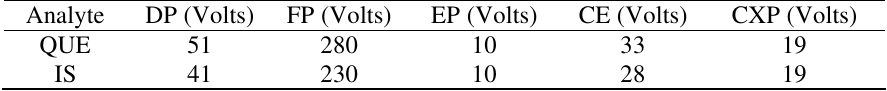
Table 1. Optimized mass spectrometry parameters for analytes and IS